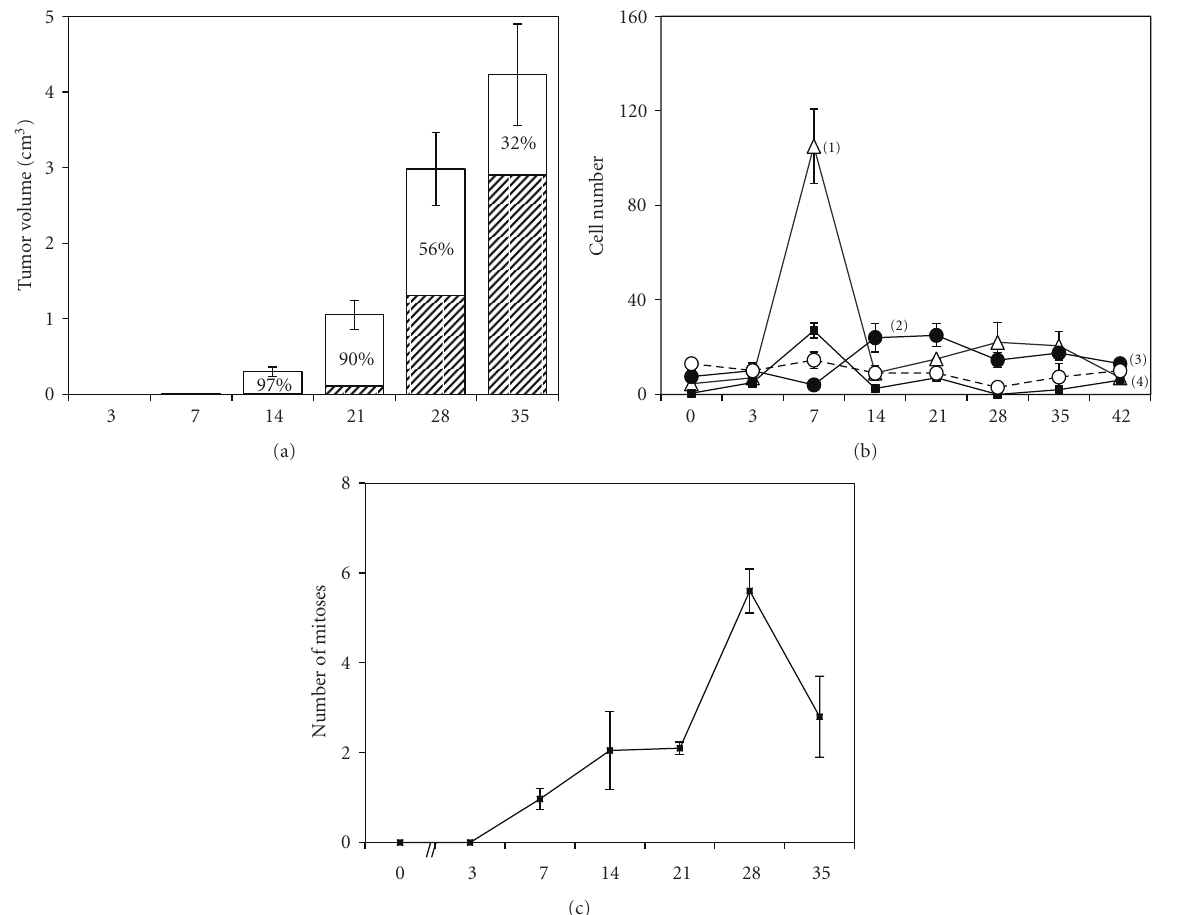
Figure 4: Morphological and histological parameters of hepatoma 22a growth (a–c). (a) Tumor volume after s.c. inoculation of 10 5 live hepatoma cells was measured on days of sacrifice; bars represent areas of viable (empty parts of the bar chart) and necrotized (dashed parts of the bar chart) tumor tissue in percent to the whole tumor volume. Areas of viable and necrotic tissues were calculated in histological sections per field of vision, magnification × 200; ten fields of vision were counted for each mice ( n = 3) (b) The mean number of lymphocytes (1), mast cells (2), polymorphonucleus leukocytes (3), and macrophages (4), infiltrating periphery of the tumor (one field of vision from the edge of the tumor), magnification of × 600 per 10 fields of vision ( n = 3) (c) The mean number of mitoses in viable areas of the tumors at magnification × 900 per 10 fields of vision ( n = 3). All values are the mean ±